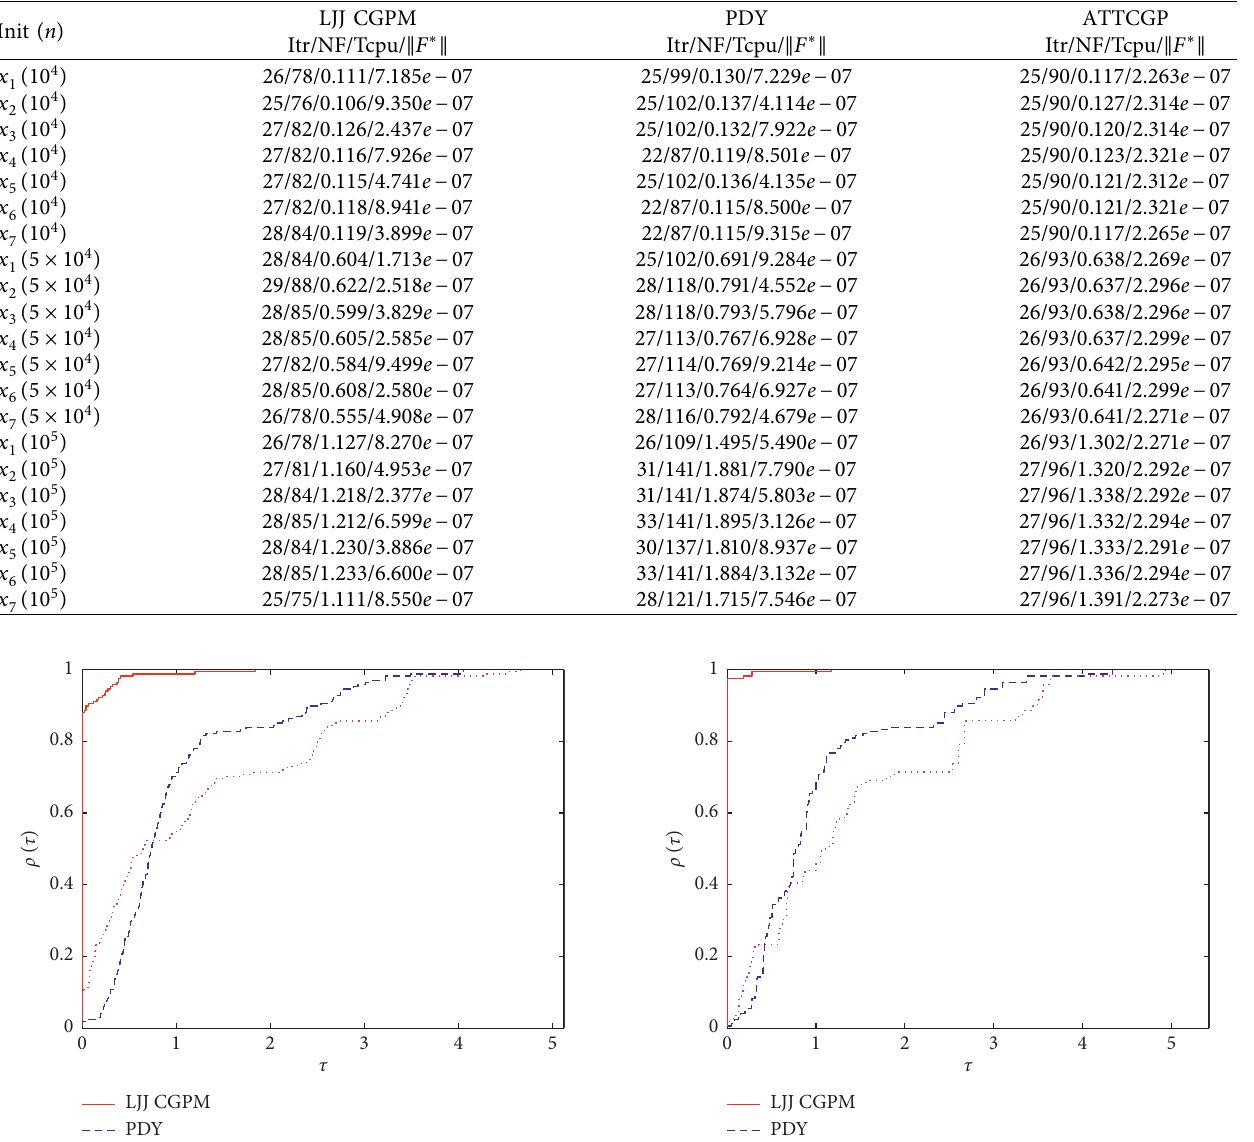
Table 8: Numerical results on Problem 8.